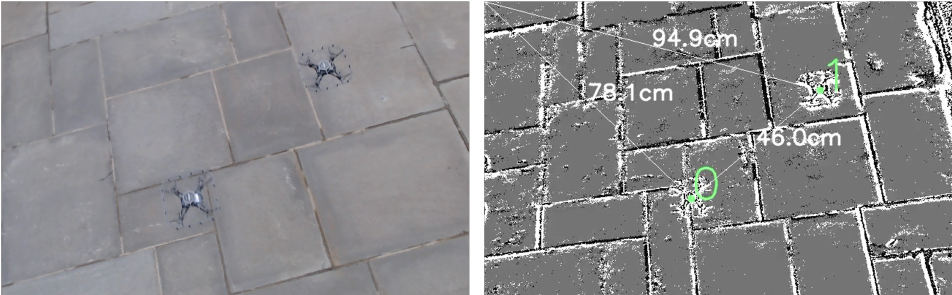
Figure 12. Experiments involving 2 quadrotors carried out in outdoor environments are depicted in RGB ( left ) and event ( right ) format. For the outdoor experiments, the RGB and event cameras were mounted at different locations on the imaging quadrotor. Due to the different camera perspectives, the quadrotors appear to be at slightly different positions in the RGB and event images shown